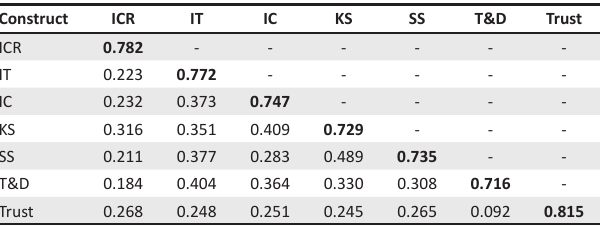
TABLE 3: Fornell and Larcker.